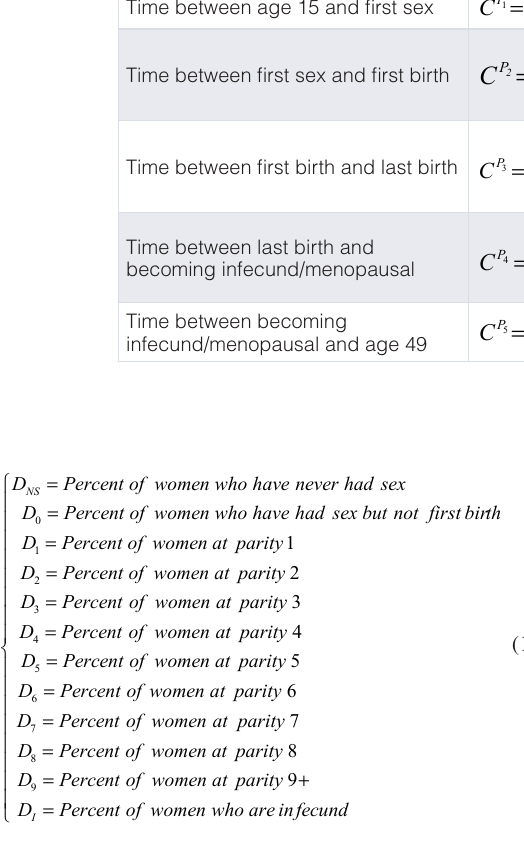
Table 1. Contraceptive use at each stage of the reproductive life course. Description